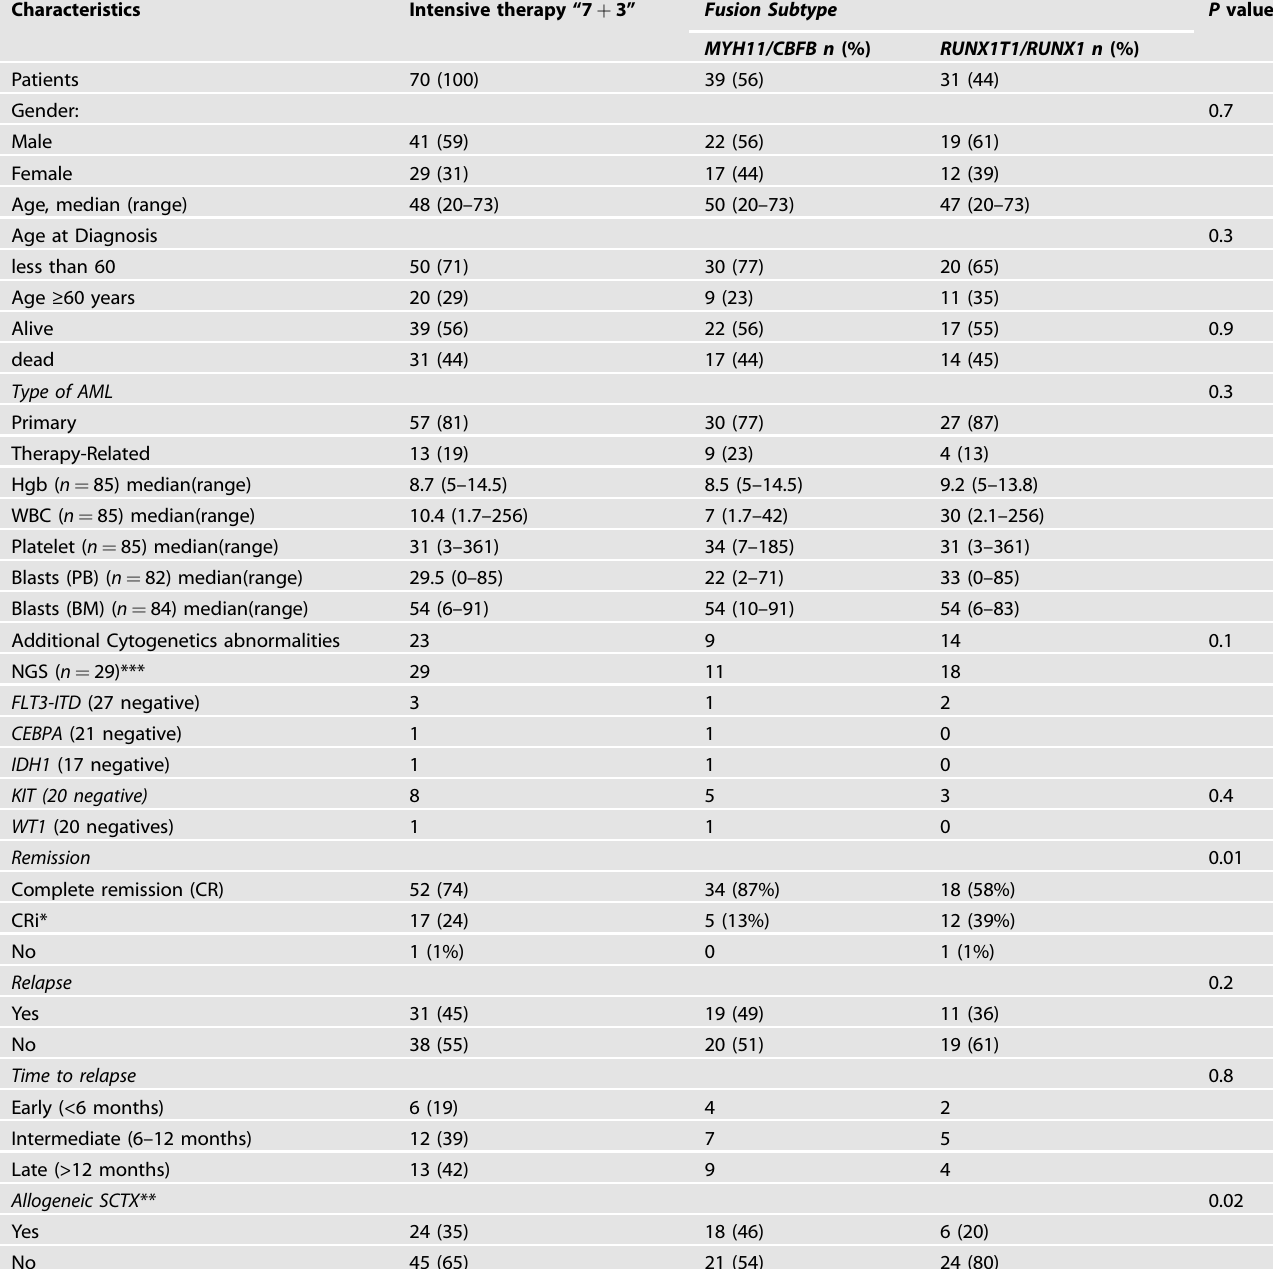
Table 1. Clinical Characteristics of CBF AML patients uniformly treated with “ 7 + 3 ”